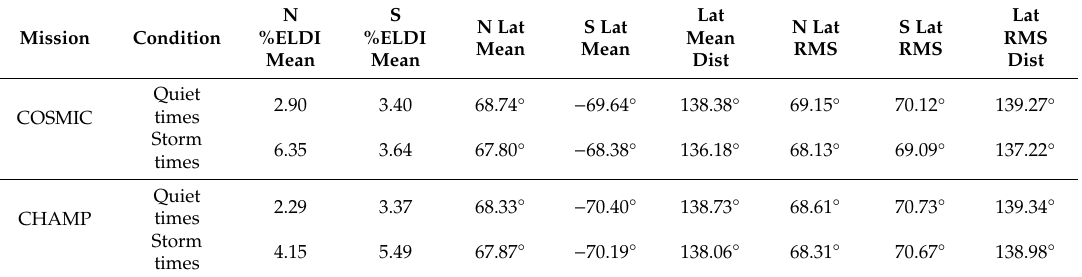
Table 2. Mean %ELDI, as well as mean and root mean square (RMS) of the latitudes weighted by %ELDI for the southern (S) and northern (N) high latitude